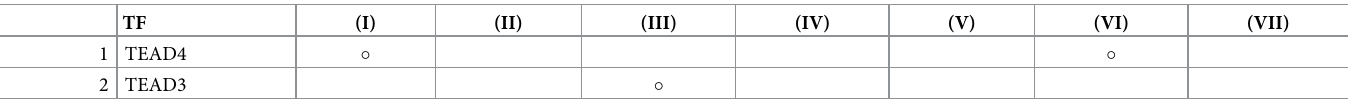
Table 5. Identification of TEAD transcription factor (TF) family members within seven TF-related categories in Enrichr. Roman numerals correspond to the first col- umn in Table 3. TF